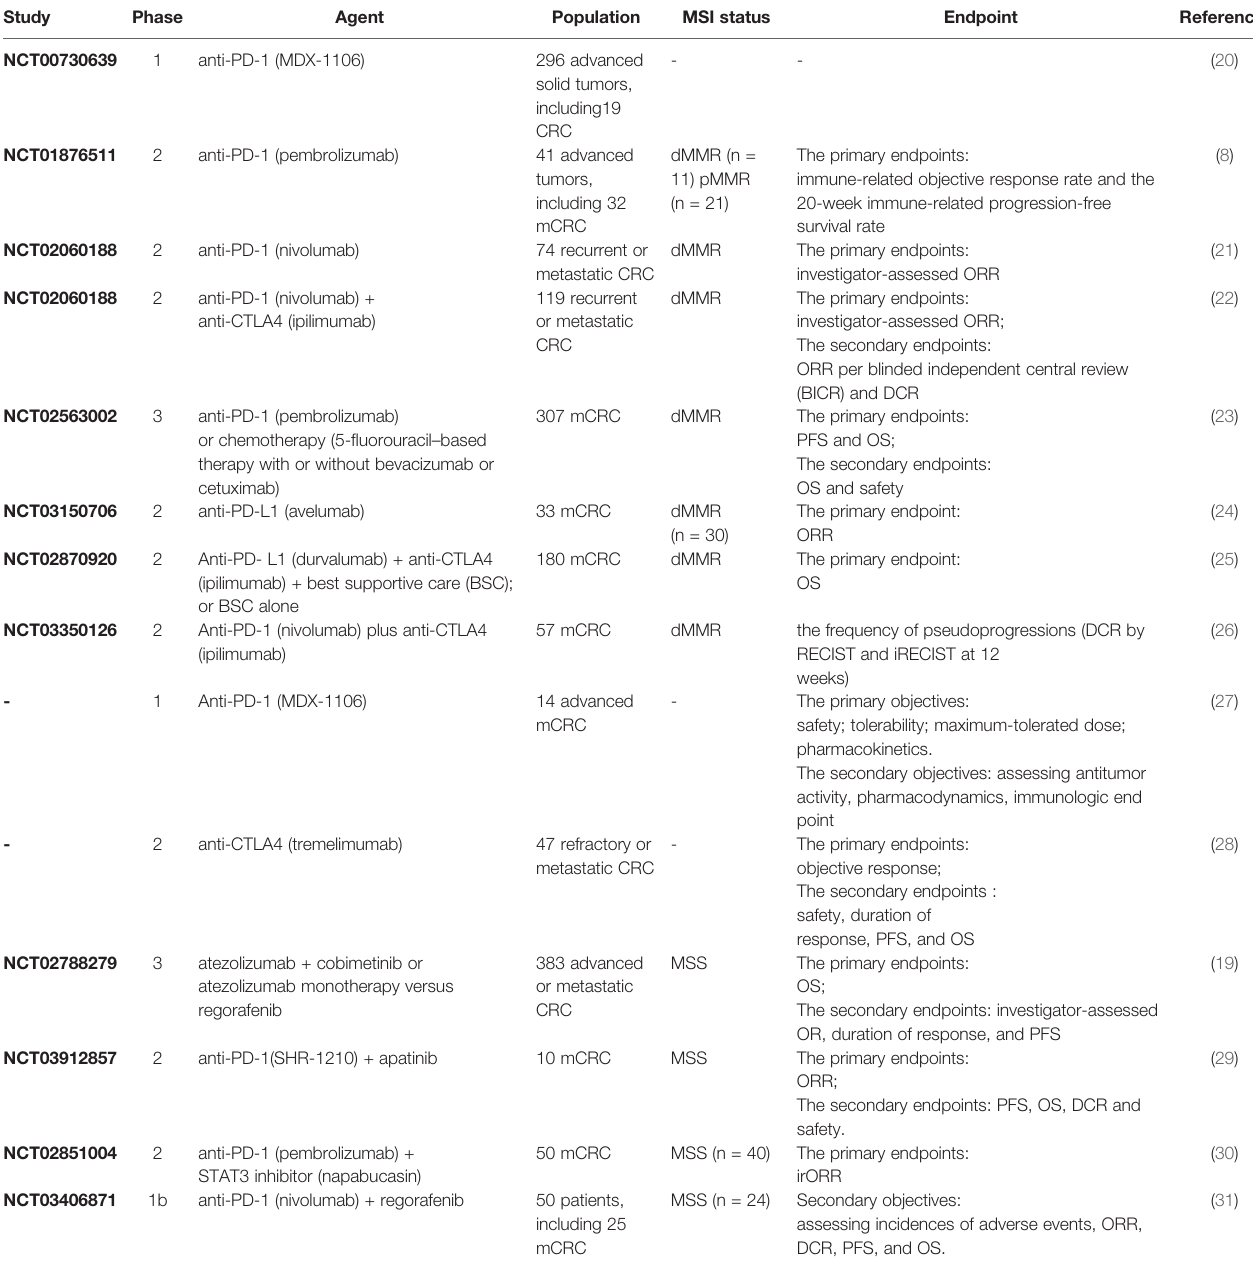
TABLE 1 | Summary of Immune Checkpoint Inhibitors Therapies for